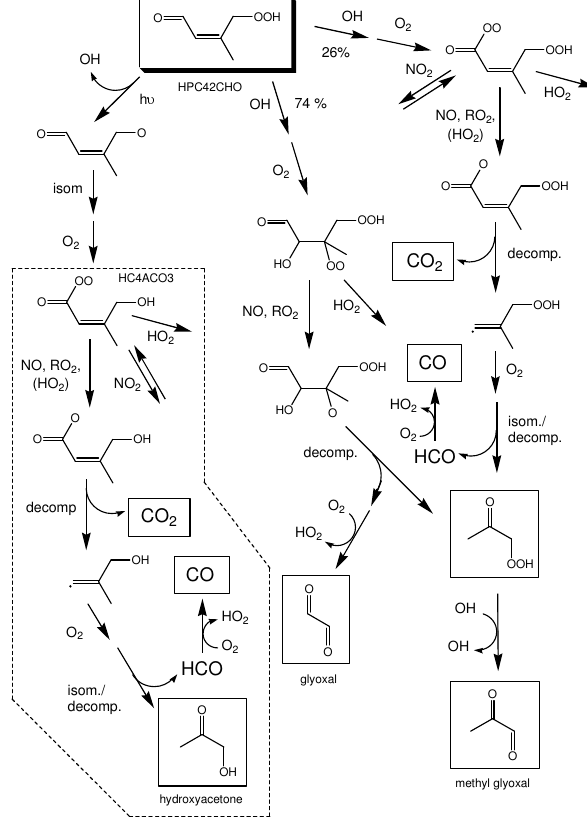
Figure 7. Schematic representation of the degradation of the HPC42CHO as initiated by reaction with OH in Mechanisms 3a – 3d, and as initiated by photolysis in Mechanisms 3b – 3d (see text). The boxed chemistry is unchanged from MCM v3.1, although it is noted that Peeters et al. (2009) suggest additional HO x formation may occur following isomerisation of HC4ACO3. For clarity, only the main propagating routes are shown, but competing reactions for peroxy radicals were fully represented in the mechanisms. Propagating channels for the reactions of HO 2 with the acyl peroxy radicals in this mechanistic extension were only represented in the consolidated Mechanism 4.